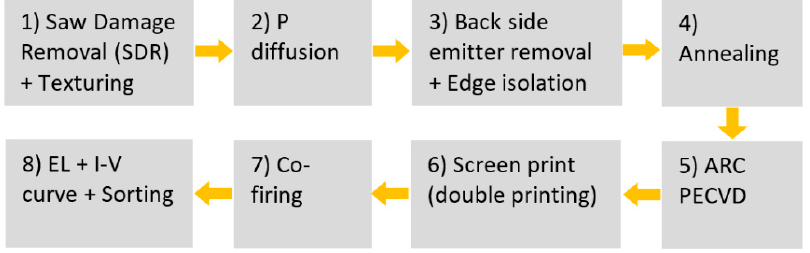
Figure 9. Descriptive sketch of Al-BSF solar cells production.